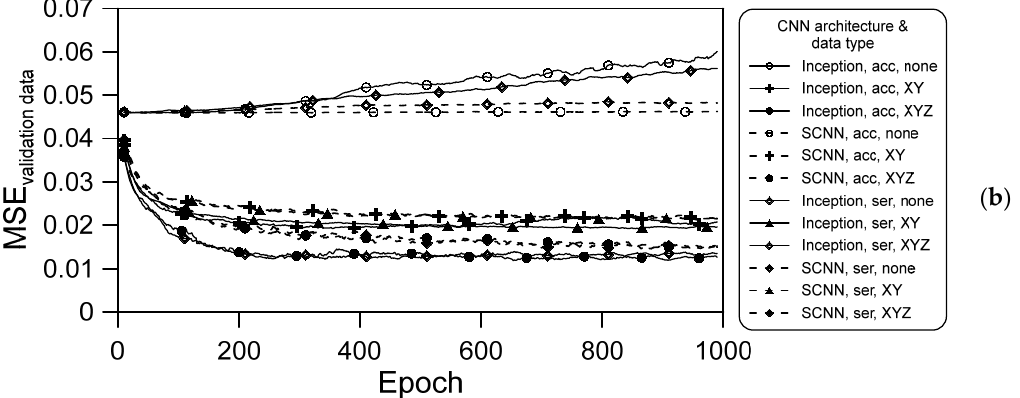
Figure 9. Convergence of the loss function for different models: ( a ) training data; and ( b ) validation data.